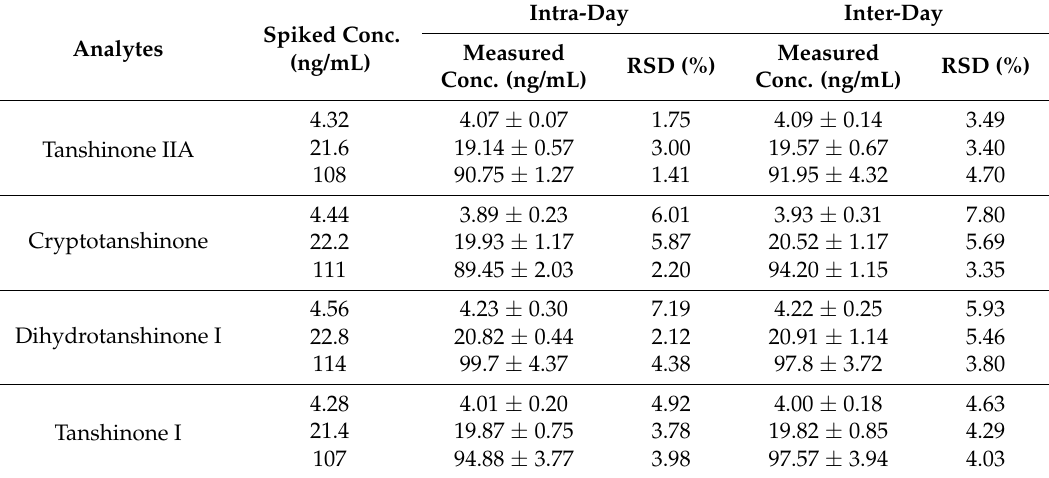
Table 3. The intra- and inter-day precisions of four tanshinones in QC samples at three concentration levels ( n = 6 replicates per